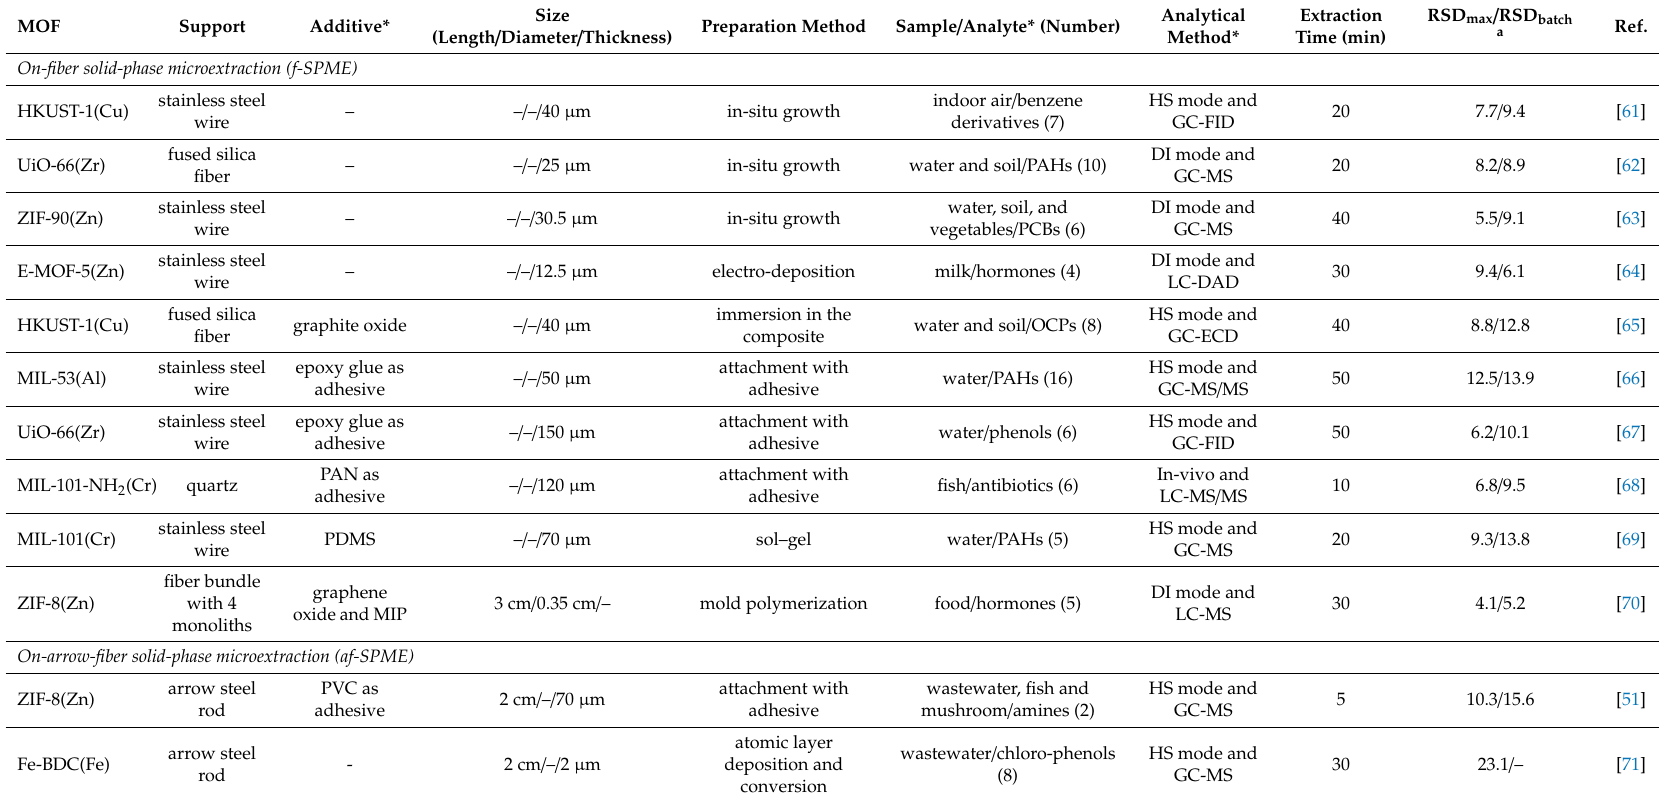
Table 1. Representative examples of MOF-based coatings prepared within all the di ff erent SPME